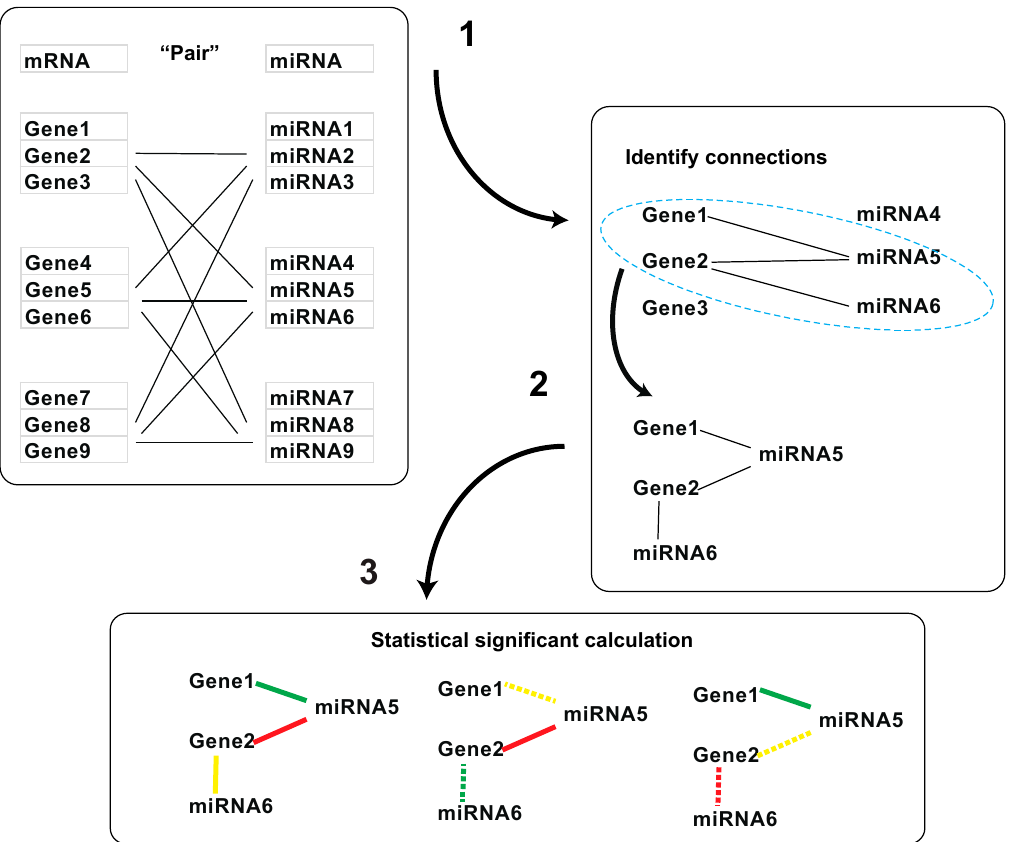
Figure 2. Workflow for statistical significance test for gene and miRNA interaction clusters: (1) miRNA and mRNA pairs with target relationship; (2) cluster identification; (3) permutation test.